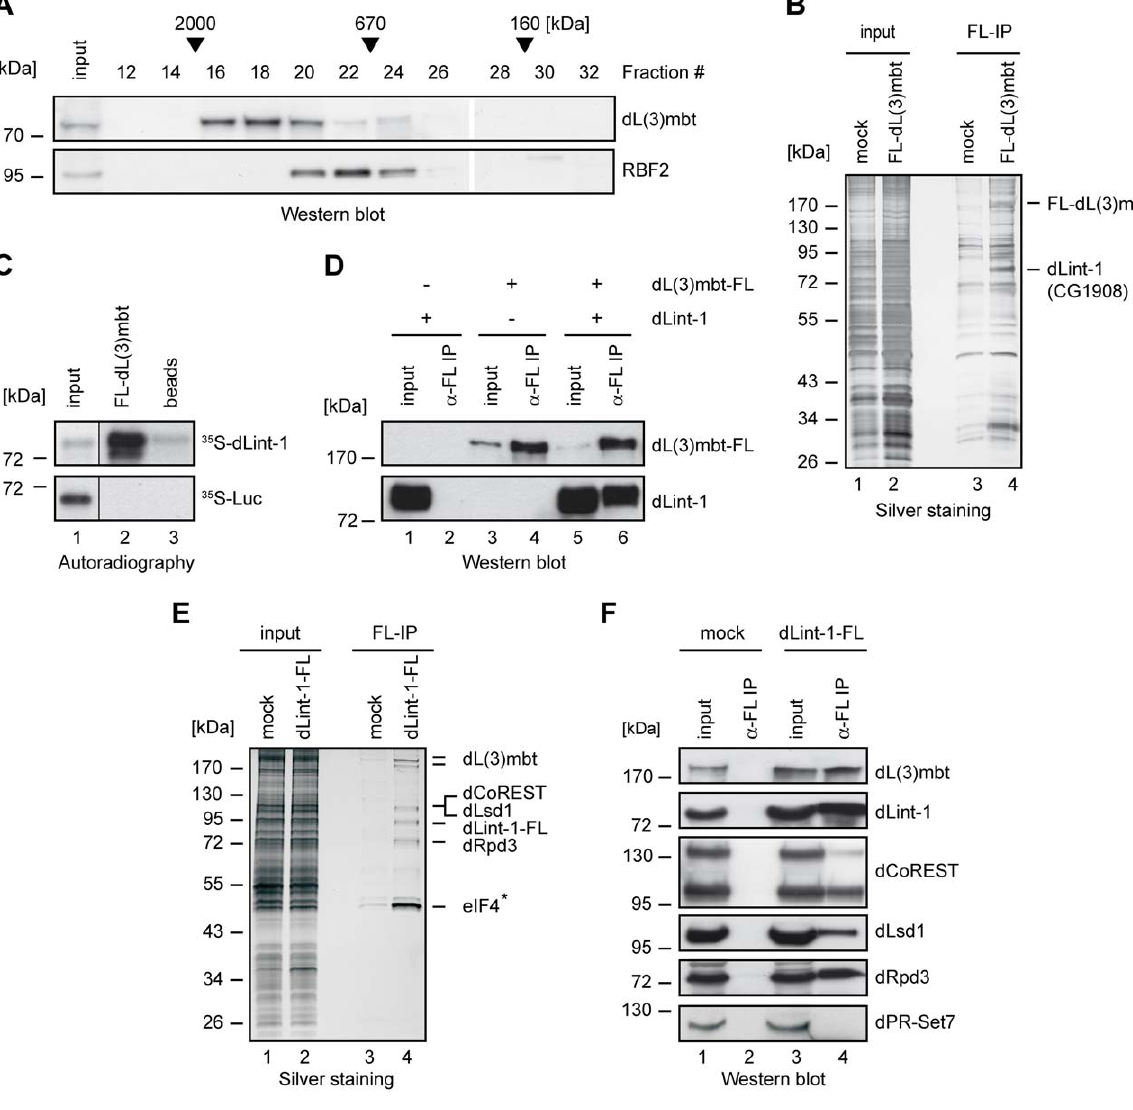
Figure 1. dLint-1 is a novel dL(3)mbt–interacting protein. (A) Nuclear extract from Kc cells was fractionated over a Superose 6 column. Fractions were analyzed by Western blot using the antibodies indicated. Fraction numbers and molecular mass standards are denoted on top. Input: 5% of extract loaded. (B) Nuclear extracts from control S2 cells (mock, lanes 1 and 3) and S2 cells stably expressing FLAG-dL(3)mbt (lanes 2 and 4) were subjected to FLAG affinity purification, elution with FLAG peptide, SDS-PAGE and silver staining (lanes 3 and 4). Input: 2 m g of nuclear extracts (lanes 1 and 2). The positions of FLAG-dL(3)mbt and dLint-1 are indicated on the right. (C) In vitro translated, 35 S-labeled dLint-1 (upper panel) or luciferase (lower panel) were incubated with FLAG beads (beads, lane 3) or beads loaded with FLAG-dL(3)mbt (lane 2). Bound proteins were separated by SDS-PAGE and detected by autoradiography. Lane 1: 1% input. (D) Sf9 cells were infected with baculoviruses expressing dL(3)mbt-FLAG or dLint-1 as indicated on top. Extracts were immunoprecipitated and subjected to Western blot using FLAG and dLint-1 # 2 antibodies (lanes 2, 4 and 6). Lanes 1, 3 and 5: 5% input. (E) Nuclear extracts from control S2 cells (mock, lanes 1 and 3) and S2 cells stably expressing dLint-1-FLAG (lanes 2 and 4) were subjected to FLAG affinity purification, elution with FLAG peptide, SDS-PAGE and silver staining (lanes 3 and 4). Input: 2 m g of nuclear extracts (lanes 1 and 2). The position of dLint-1-FLAG and copurifying proteins are indicated on the right. * denotes that eIF-4B was also recovered from the control and is considered to be a contaminant. Note that dCoREST and dLsd1 have the same molecular weight and comigrate. (F) Nuclear extracts from control S2 cells (mock, lanes 1 and 2) and S2 cells stably expressing FLAG-dLint-1 (lanes 3 and 4) were precipitated with FLAG antibody and analyzed by Western blot as indicated (lanes 2 and 4). dPR-Set7 served as a negative control. Lanes 1 and 3: 5% input. dL(3)mbt (Figure 3). Costaining with dLint-1 antibody revealed appeared to be bound by dL(3)mbt only. These results show that extensive colocalisation between both proteins. We visually dL(3)mbt and dLint-1 can cooccupy many chromatin regions on assessed 466 bands for dL(3)mbt and dLint-1 binding (see polytene chromosomes suggesting that these two proteins not only Methods). 83% of these were stained by both antibodies, 12% associate in soluble nuclear extracts but also when bound to showed dLint-1 but no or very weak dL(3)mbt binding and 5% chromatin.